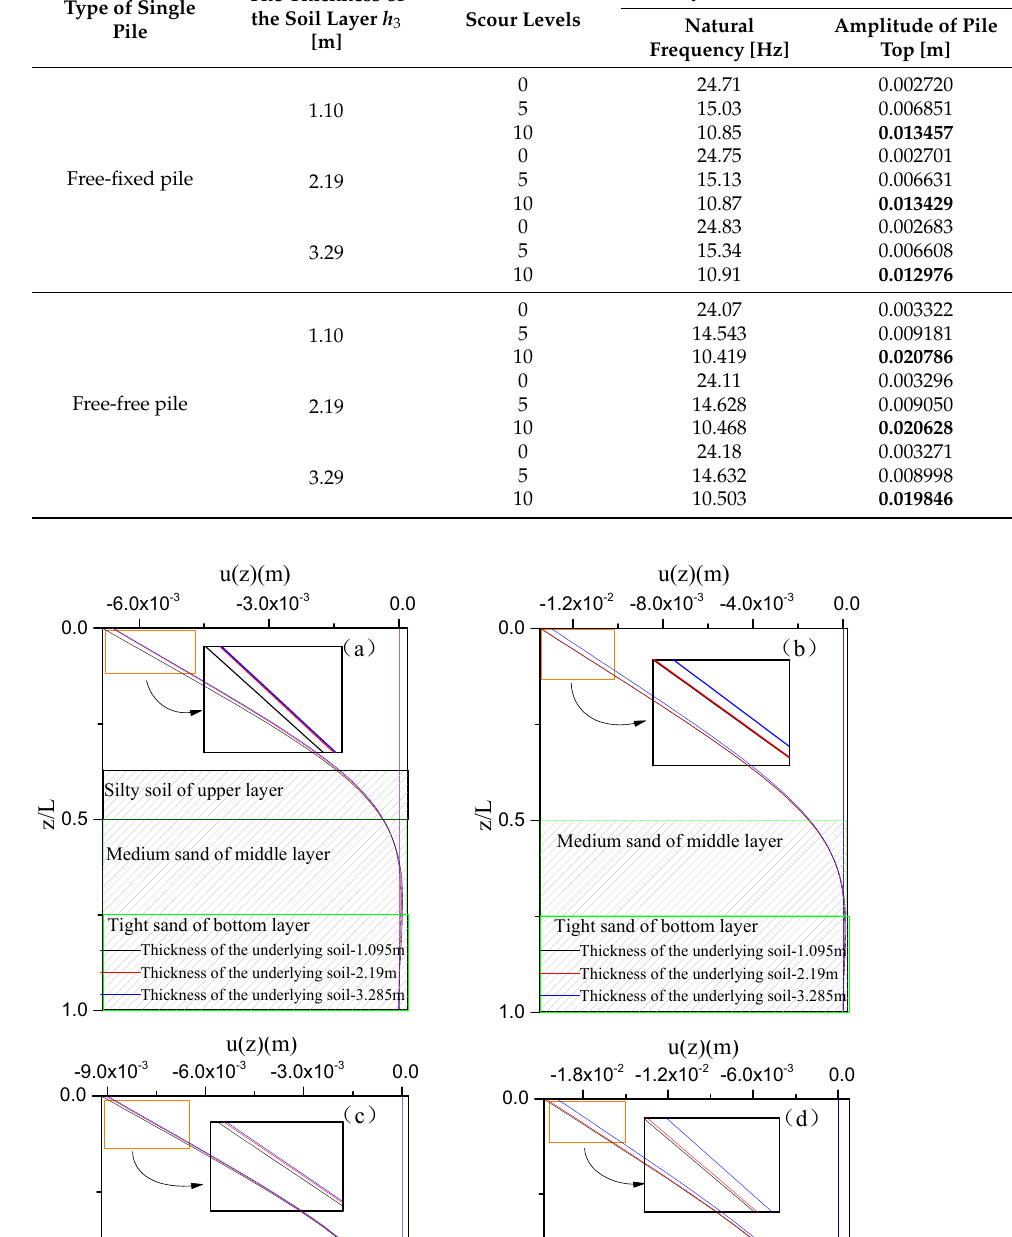
Table 3. Effect of the thickness of the underlying soil on dynamic characteristics of the single pile under varied scour levels.